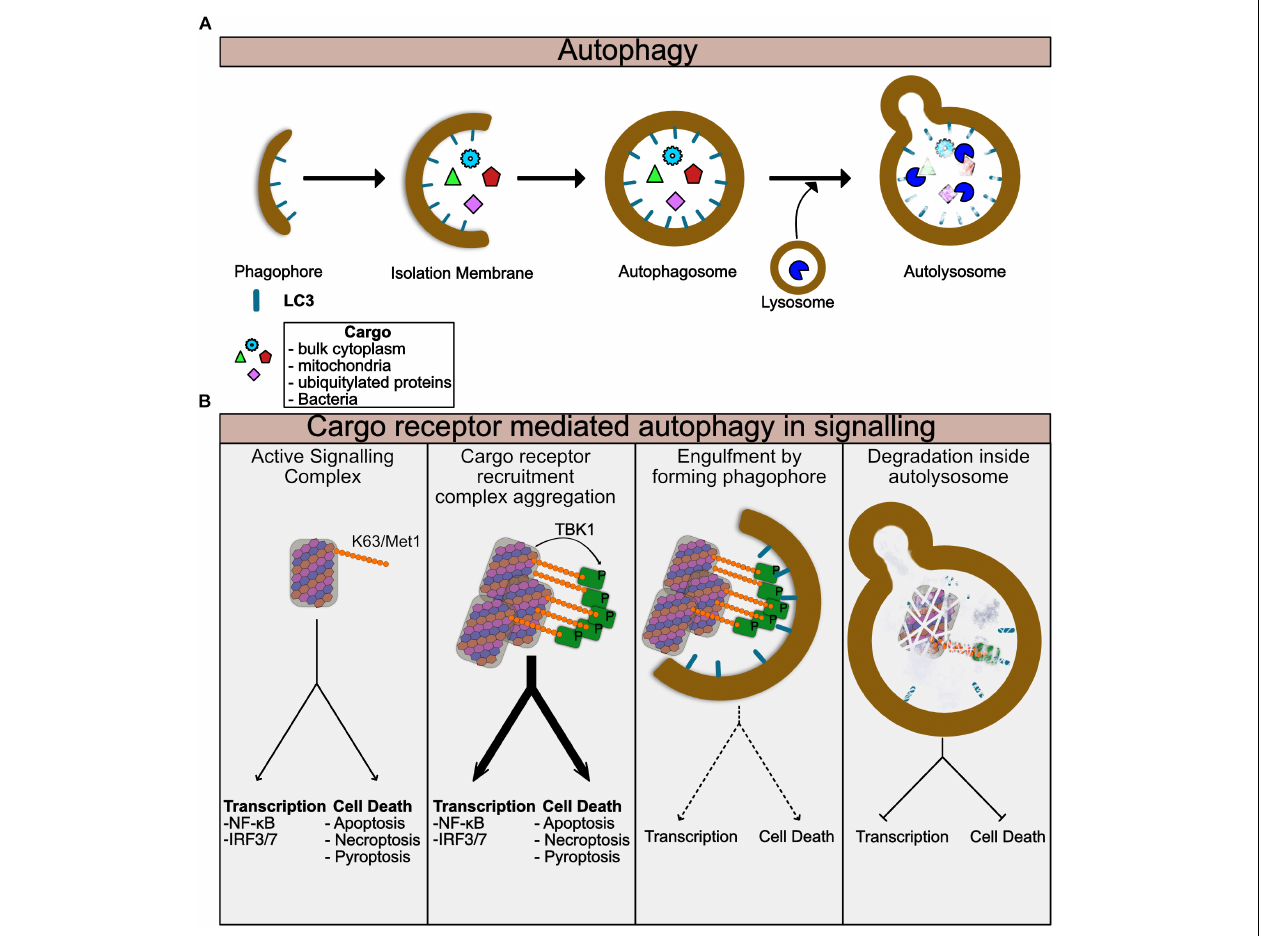
FIGURE 2 | Autophagy regulates turnover of Supramolecular complexes. (A) Summary of general autophagic process. The autophagic machinery including LC3 is recruited to the donour membrane and forms the phagophore. This then extends to form the isolation membrane which begins to engulf cytoplasmic or ubiquitylated contents. Eventually the enclosed autophagosome is formed which then can fuse with lysosomes to form the autolysosome. Lysosomal enzymes then degrade the contents of the autolysosome. (B) Summary of specific autophagy mediated by cargo receptors. Assembled supramolecular signaling complexes begin their signaling response. Cargo receptors such as p62 are recruited via K63 ubiquitin chains on the complex. TBK1 which has been activated and recruited to the complex phosphorylates the cargo receptor to enhance its recruitment. At this stage the signal from the complex may be amplified due to clustering of multiple complexes together or perhaps further enhancement of the localized proximity of kinases, caspases, and ubiquitin ligases for example. As the cargo:cargo-receptor complexes are engulfed by the forming autophagosome, signaling will be reduced. Finally, degradation of the complex within the autolysosome completes the cycle and the complex is